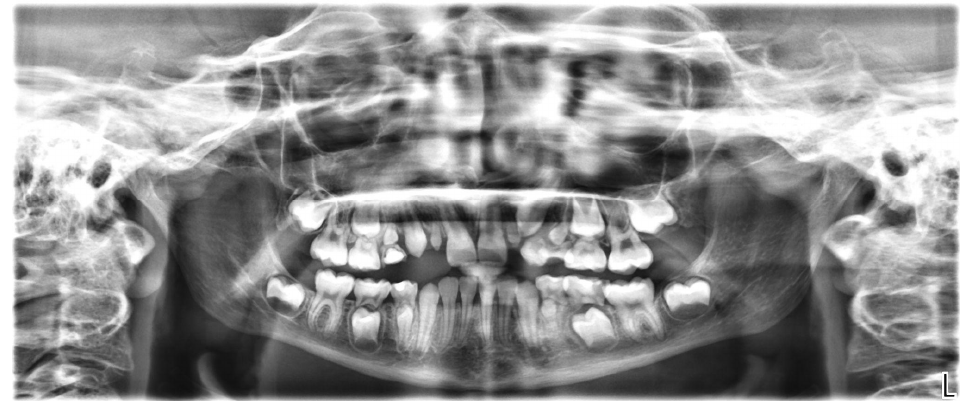
Figure 5. Orthopantomogram of a 9-year-old girl showing reduced size of teeth 14, 12, 22, 24, 34, and 44.